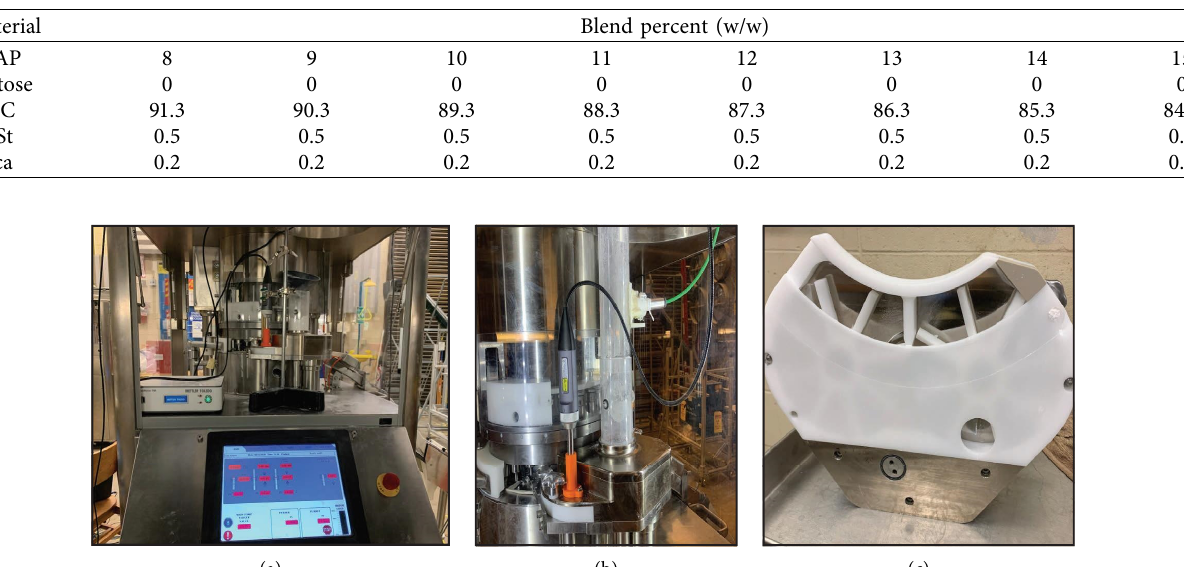
Table 2: Blend composition for APAP in MCC.